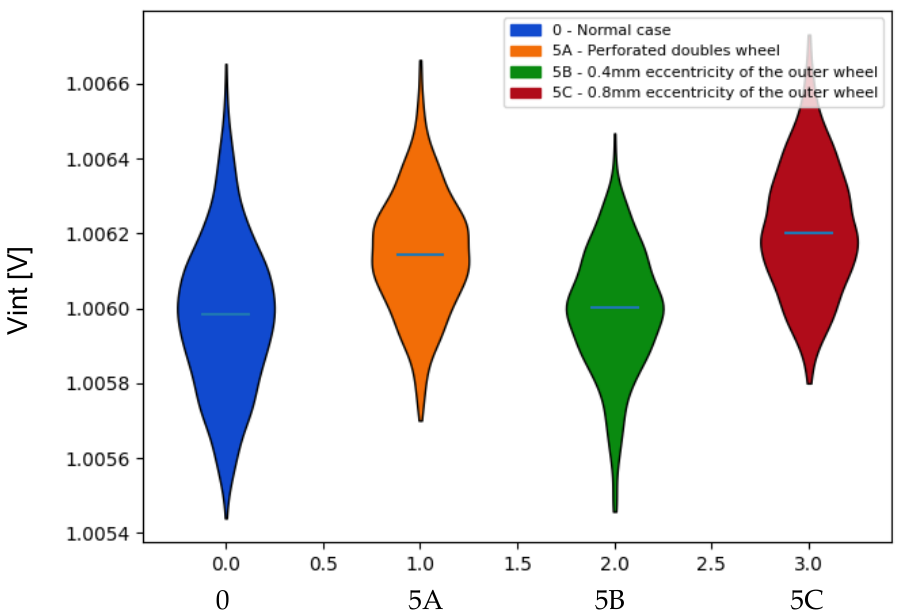
Figure 21. Comparison of the probability distributions obtained for the mean values of the voltage Vint in the case of failures associated with the double sensors. Indicator: mean. Table 8. Kullback–Leibler divergence values associated with the means associated with the average values of the Vint voltage for the identification of the failures associated with the double sensors.